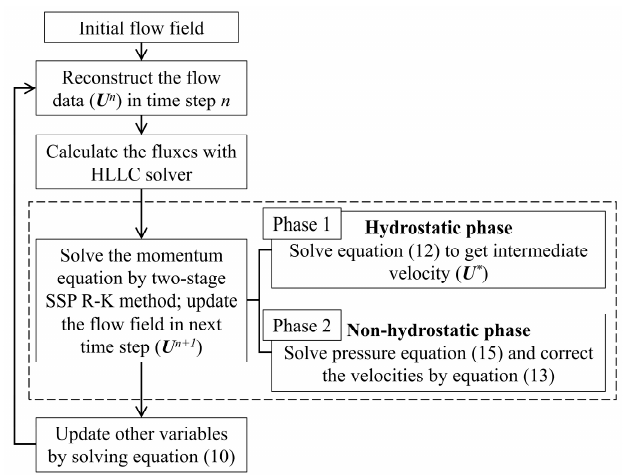
Figure 4. Flow chart of the solution procedure of the NHWAVE model.